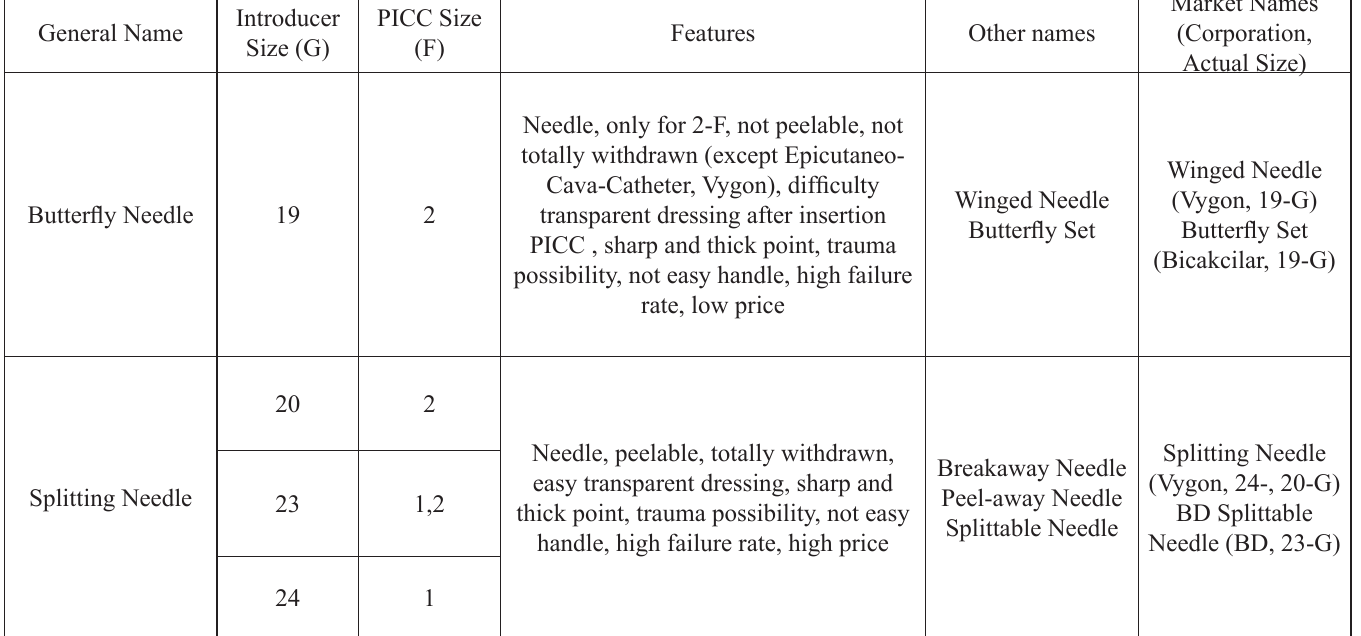
Table 4. Completion of therapy and removed after death were achieved with 87% of PICCs.